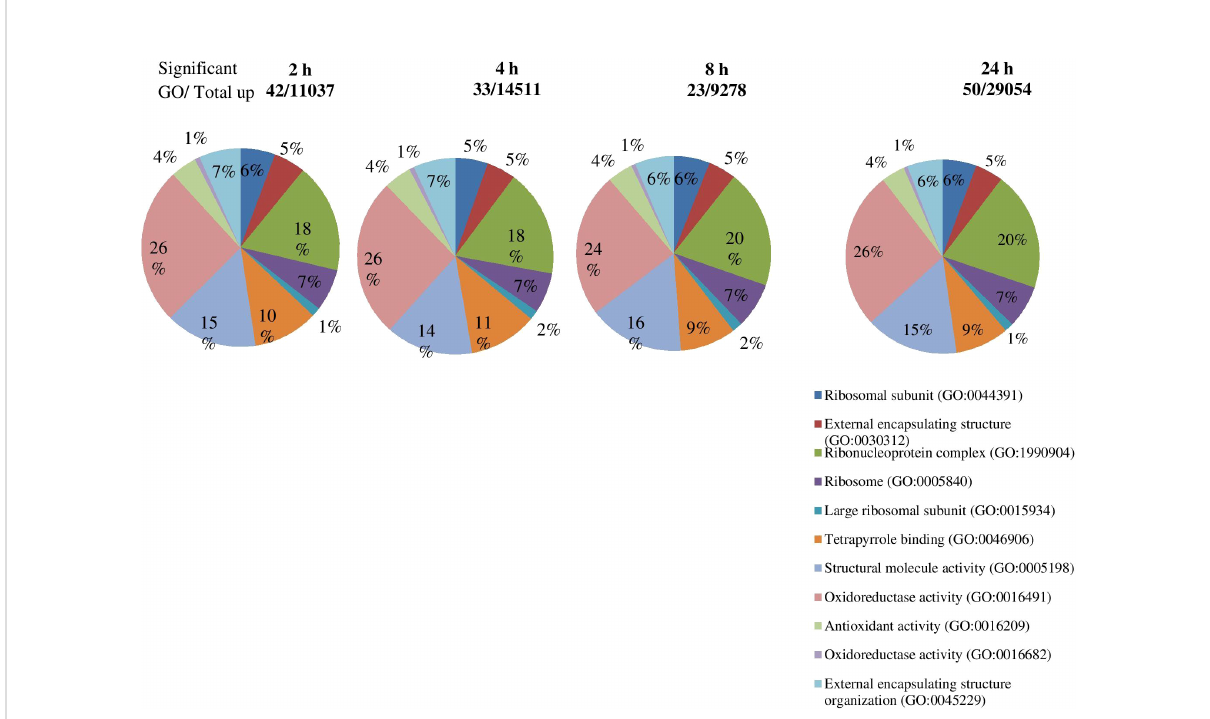
FIGURE 7 Signi fi cant GO enrichment analysis of genes in roots tips of S. spontaneum plants in response to drought stress. The number of upregulated genes identi fi ed in each comparison of speci fi c time